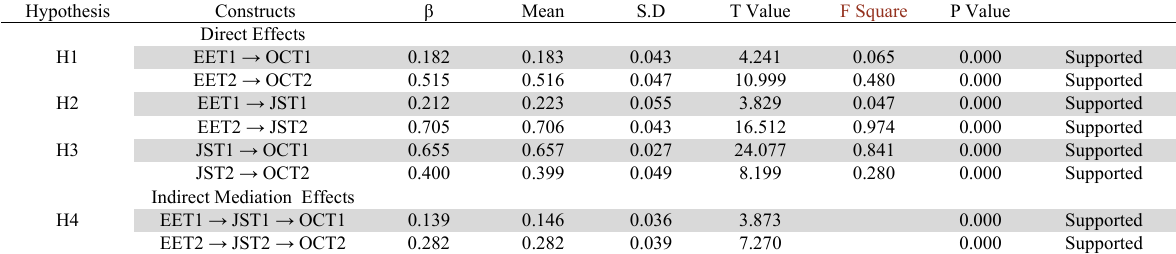
Structural Equations Model